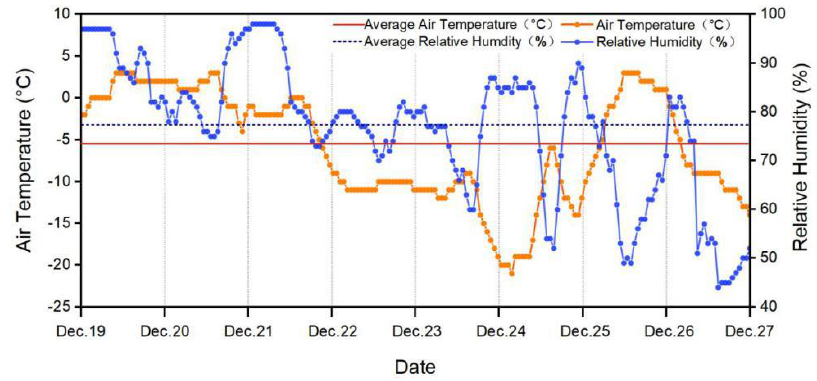
Figure 3. Outdoor air temperature and humidity during the measurement period.